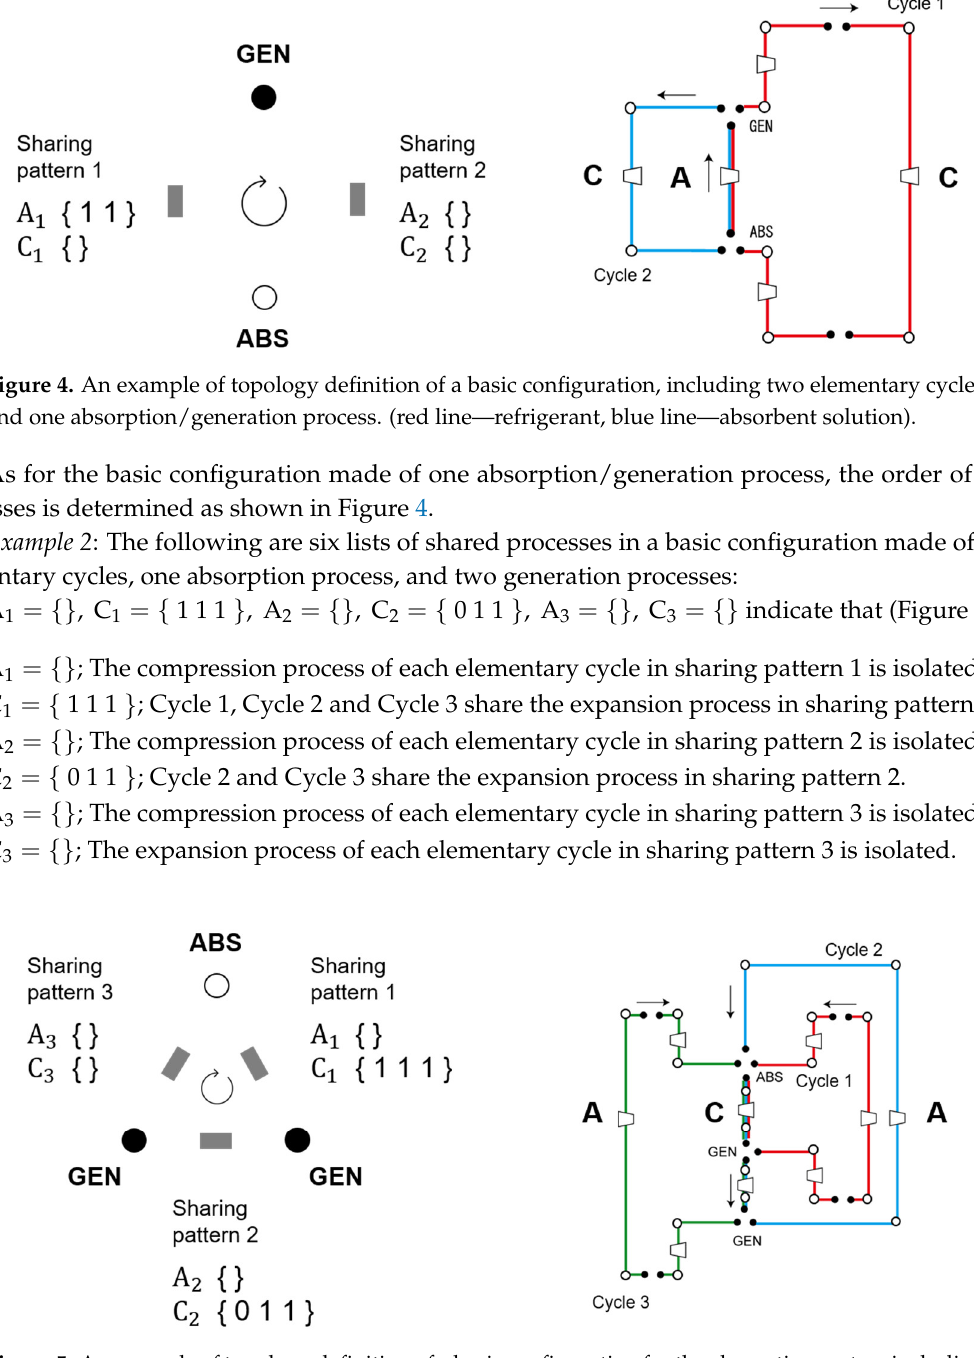
Figure 5. An example of topology definition of a basic configuration for the absorption system including three elementary cycles and one absorption process and two generation processes. (red line, green line—refrigerant, blue line—absorbent solution).